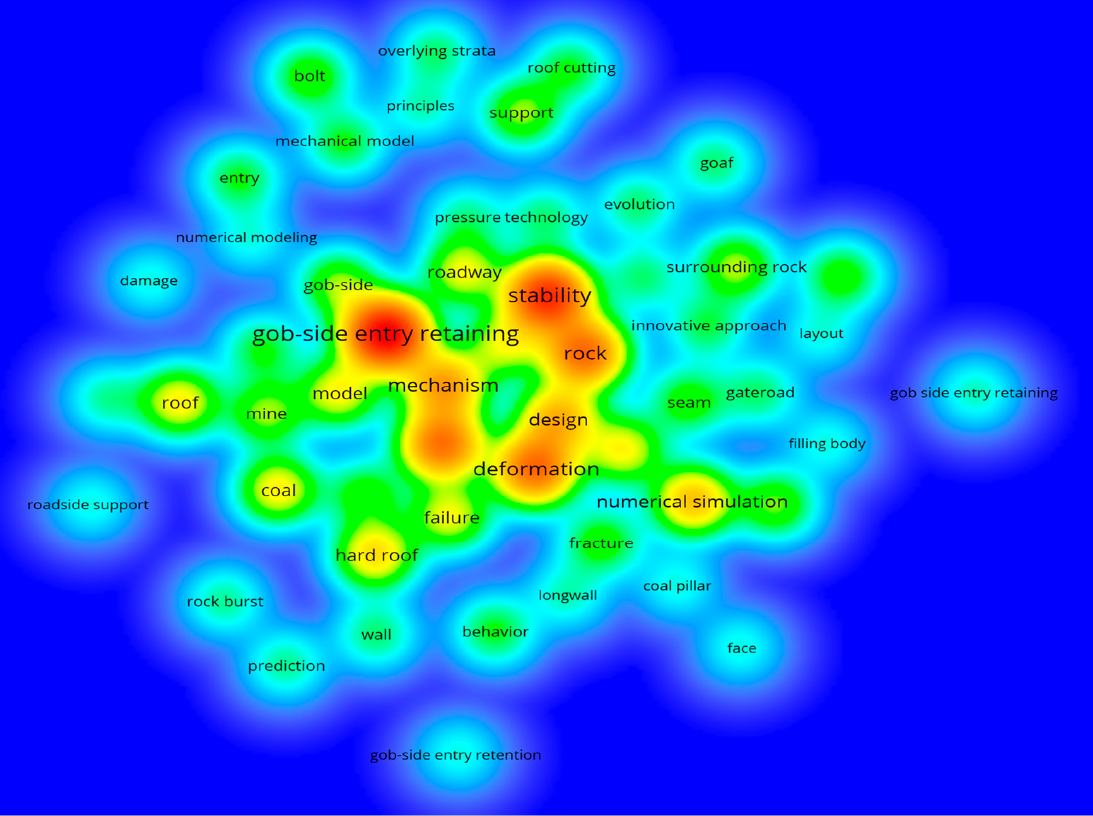
Figure 2. Research hotspot map of gob-side entry driving in fully mechanized caving.